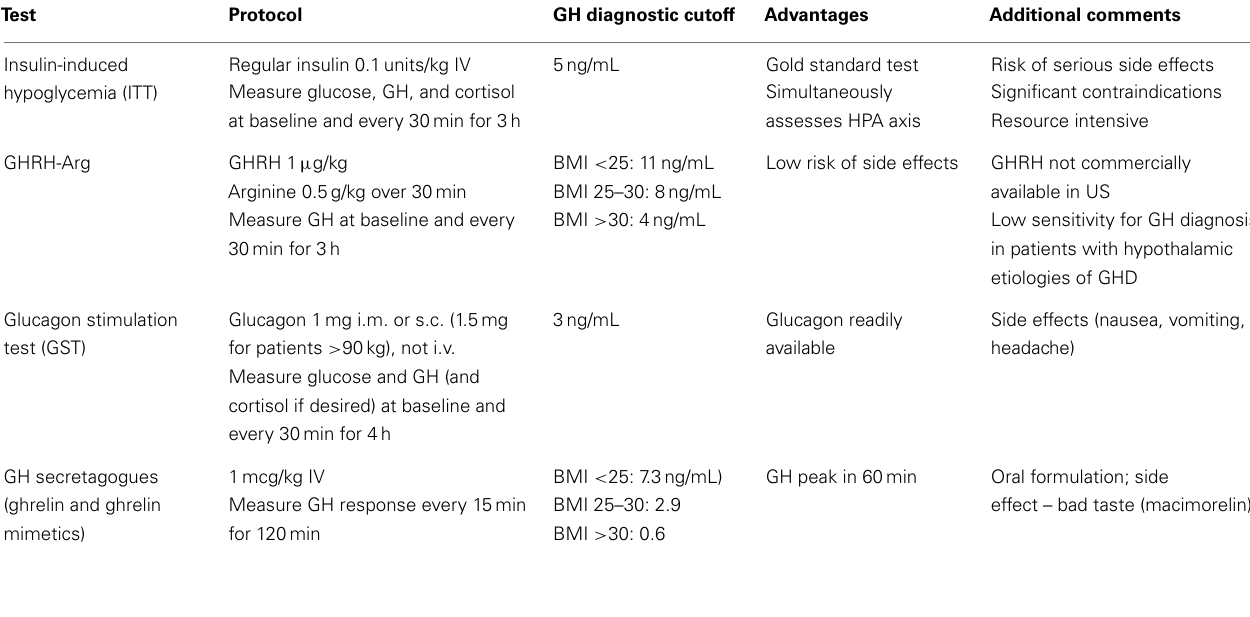
Table 3 | Comparison of GH ProvocativeTests (Kargi and Merriam,